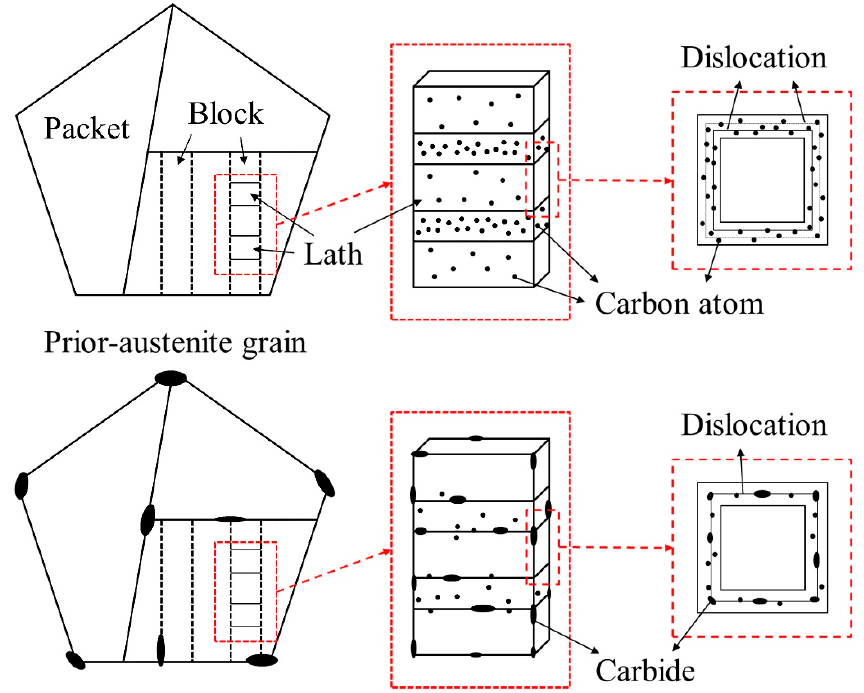
Figure 10. Schematic illustration of the evolution of martensite, carbides, and dislocations after a long-lasting tempering.